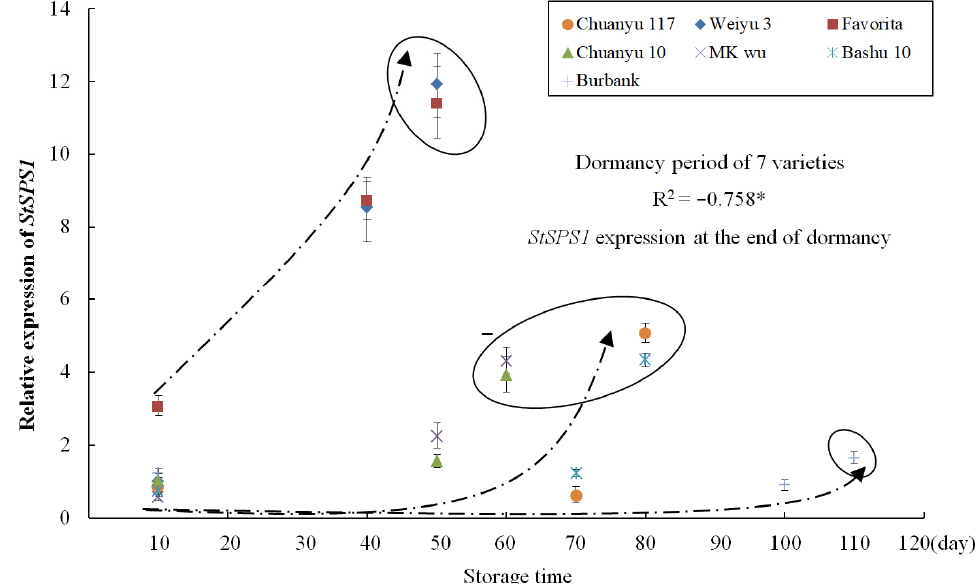
Figure 6. Correlation analysis between StSPS1 expression and tuber dormancy period of different varieties. Names of 7 potato varieties were listed in the rectangle ‘R2’ represents a correlation coefficient. ‘*’ represents a significant difference level at p < 0.05, and the circle marks the end of dormancy. The dotted arrows from top to bottom indicate the expression trend line of StSPS1